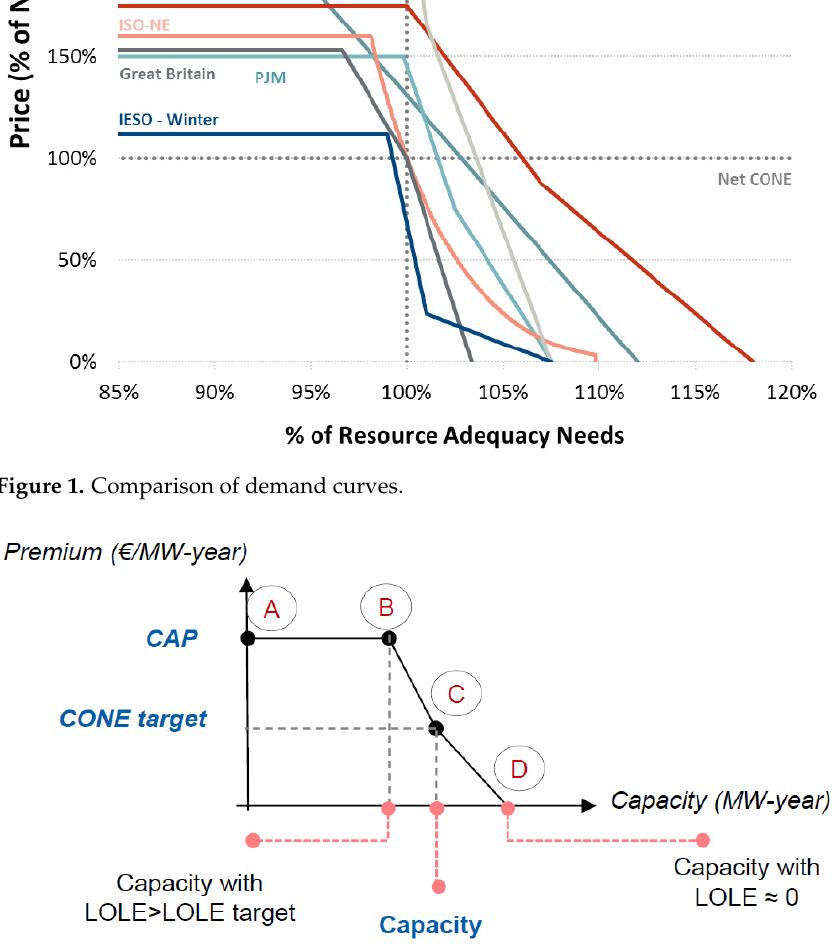
Figure 2. Typical demand curve in the Italian capacity market.